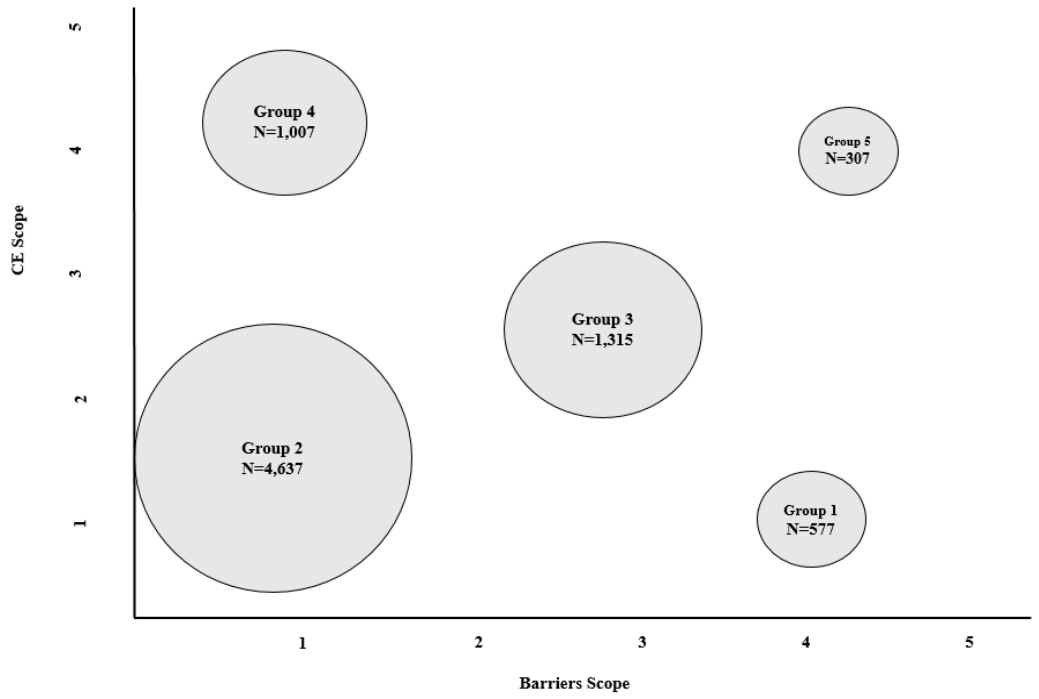
Figure 2. CE Scope and Barriers to CE Scope.